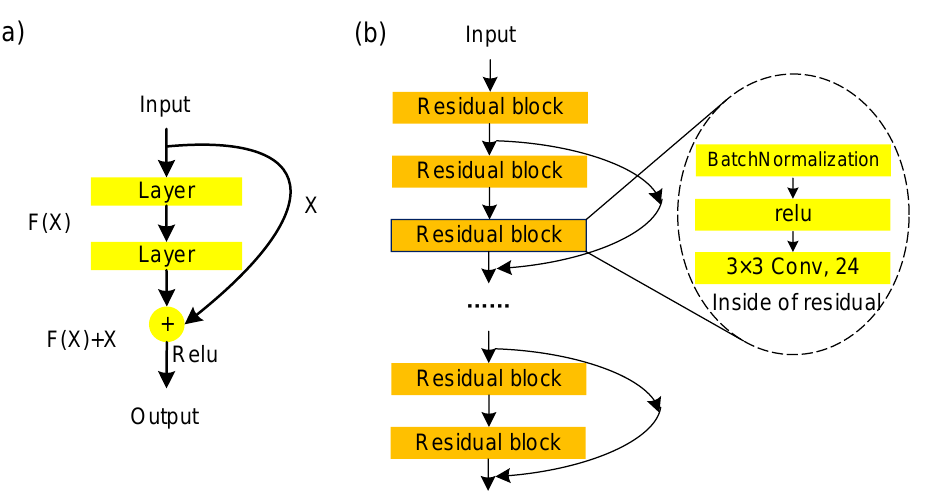
Figure 4. The residual block ( a ) and the residual network ( b ). Here X ∈ R m × n is any two-dimensional input signal. F ( X ) ∈ R m × n represents the transform by the residual block.